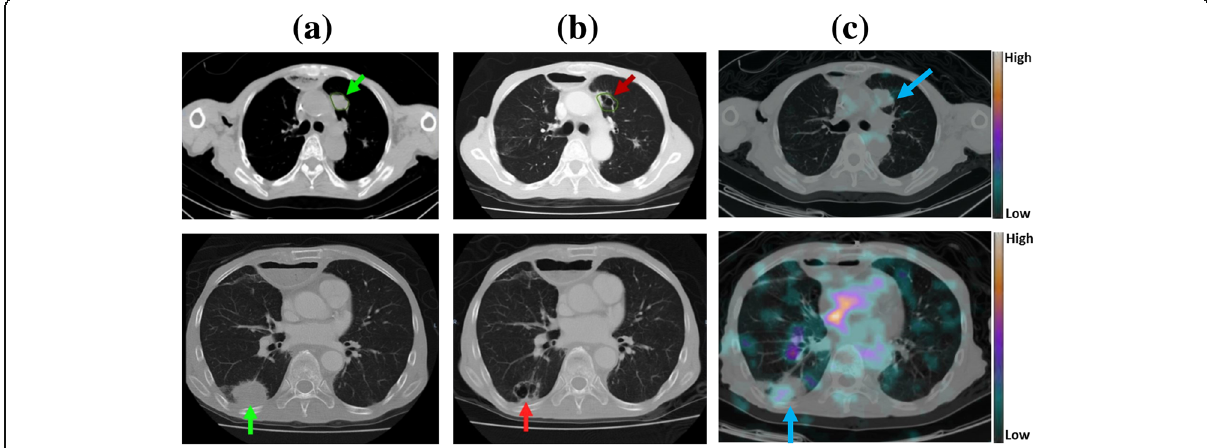
Fig. 4 A series of chest CT images for patient 11, who had esophageal cancer and lung metastases tumors: a 1month before and b 4months after 188 Re- liposome injection, the metastatic lesions (green arrows) either decrease in size or show signs of cavitation (red arrows) and c SPECT/CT images captured at 8h after 188 Re-liposome injection show a high uptake and efficient targeting in the corresponding tumor lesion (blue arrow), which is seen on